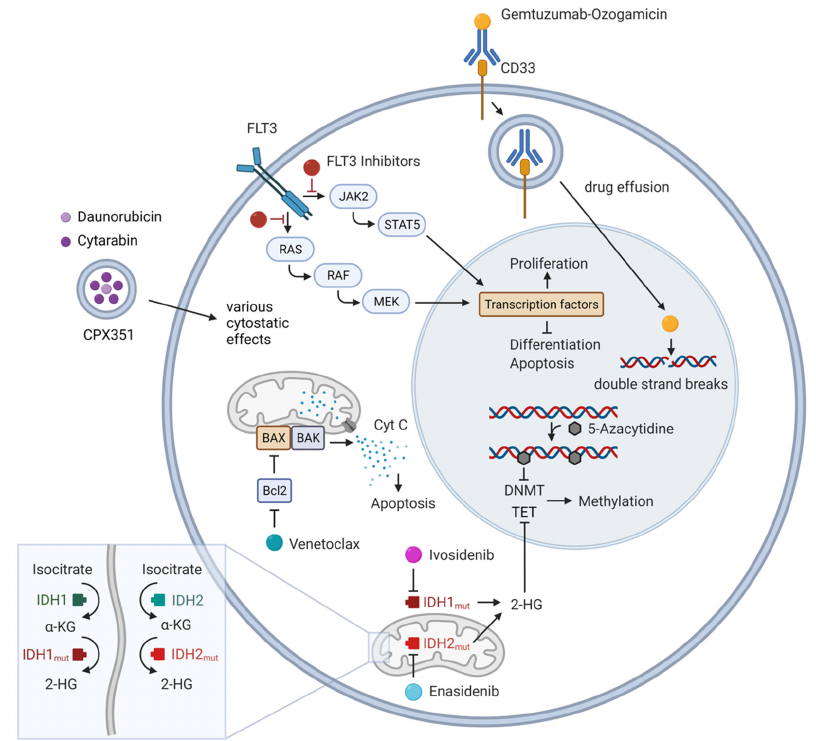
Figure 1. Schematic overview of the therapeutic agents discussed in this article and their mechanisms of action in acute myeloid leukemia. Abbreviations: BAK, Bcl-2 homologous antagonist/killer; BAX, Bcl-2 associated X protein; BCL-2, B-cell Lymphoma 2; DNMT, DNA methyltransferase; FLT3, FMS-like tyrosine kinase 3; 2-HG, 2-hydroxyglutarate; IDH, Isocitrate dehydrogenase; JAK, janus kinase; α -KG, α -ketoglutarate; MEK, mitogen-activated protein kinase; RAF, rapidly growing fibro- sarcoma; RAS, rat sarcoma; STAT5, signal transducer and activator of transcription 5; TET, ten- eleven translocation methylcytosine dioxygenase. Created with BioRender.com. (accessed on 10 March 2022) 2. Targetable Gene Mutations 2.1. FLT3 Inhibitors The human FMS-like tyrosine kinase 3 ( FLT3 ) gene, located on chromosome 13q12, encodes for a class III receptor tyrosine kinase, which is preferably expressed in myeloid and lymphoid progenitor cells [13]. Once activated by the FLT3 ligand, it promotes cell proliferation and prevents cell apoptosis through PI3K (phosphatidylinositol 3-kinase) and RAS-regulated signaling pathways (Figure 1) [14,15]. Approximately one third of newly diagnosed AML patients harbor a FLT3 mutation and FLT3 is therefore considered one of the most frequently mutated genes in AML [2]. Activating mutations of the FLT3 gene most commonly occur as either internal tandem